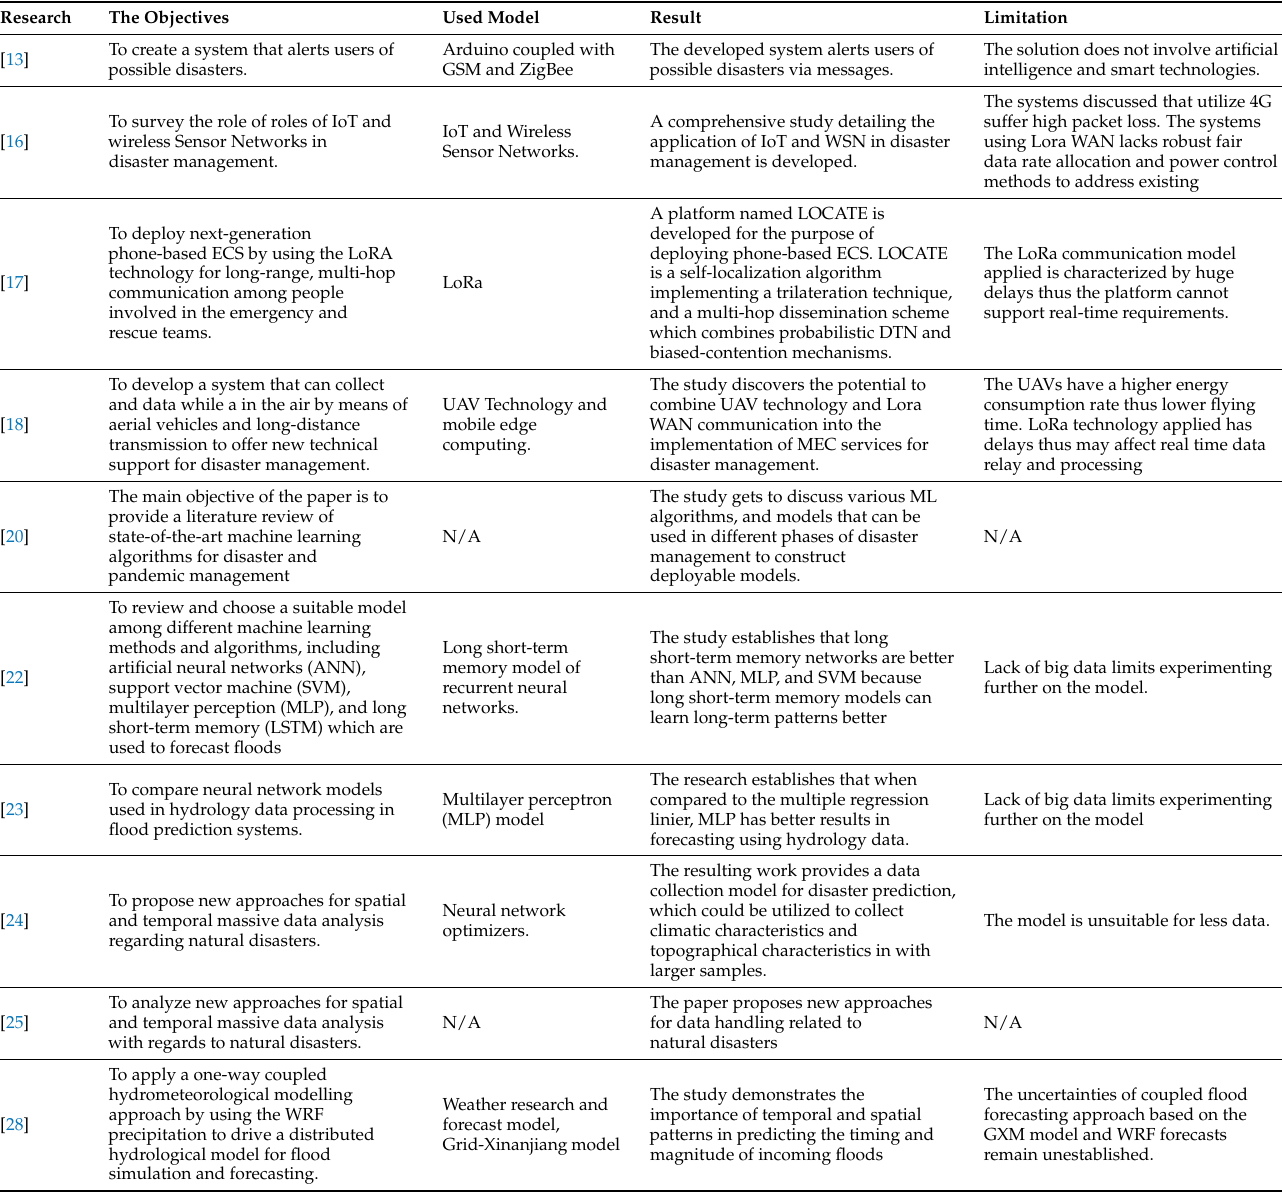
Table 1. Summary of the literature